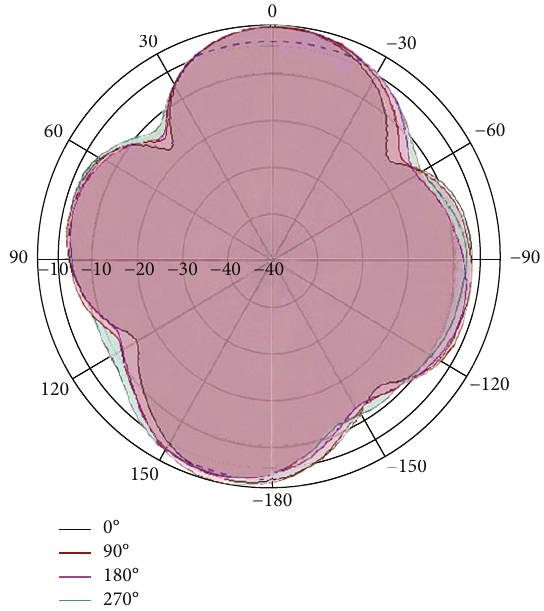
Figure 14: Measured radiation pattern (gain) of the dual-element antenna array ( S ,